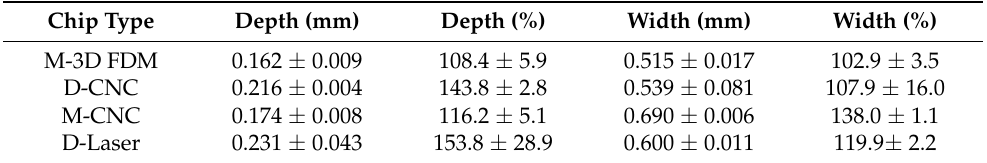
Table 3. Statistics on the depths and widths of 3D FDM, D-CNC, M-CNC and laser-engraved straight microchannels as fabricated in a low-priced 3-in-1 3D printer device. Each value is the average of determinations at three cross-sections of a representative example of the microchannel chip